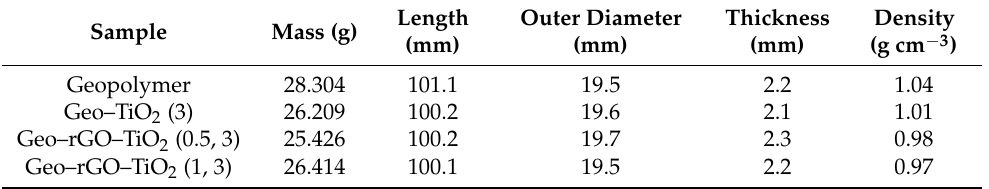
Table 2. The physical properties of the resulting Geo–rGO–TiO 2 nanocomposites depicted in Figure 1. Sample